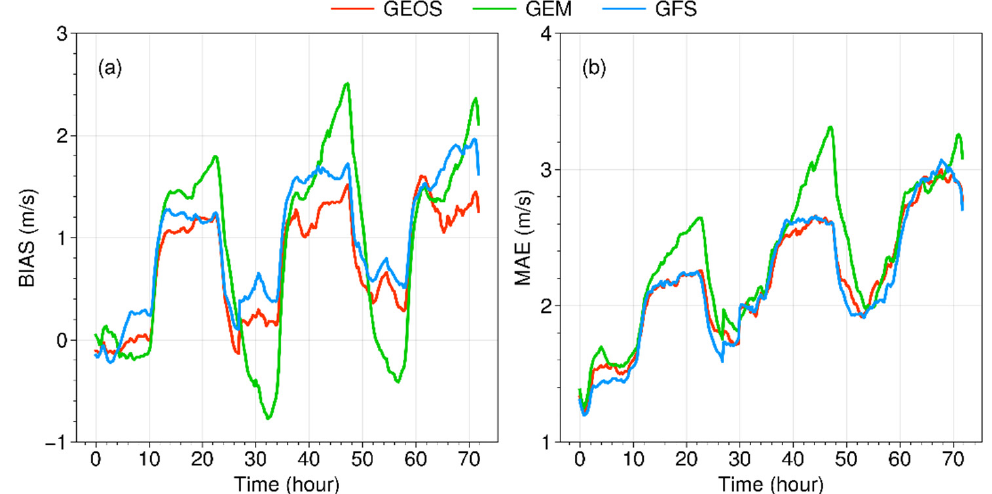
Figure 8. Variation in wind speed forecast errors with forecast time for the ensemble groups driven by the three global model forecasts: ( a ) BIAS and ( b ) MAE. The x-axis represents the time